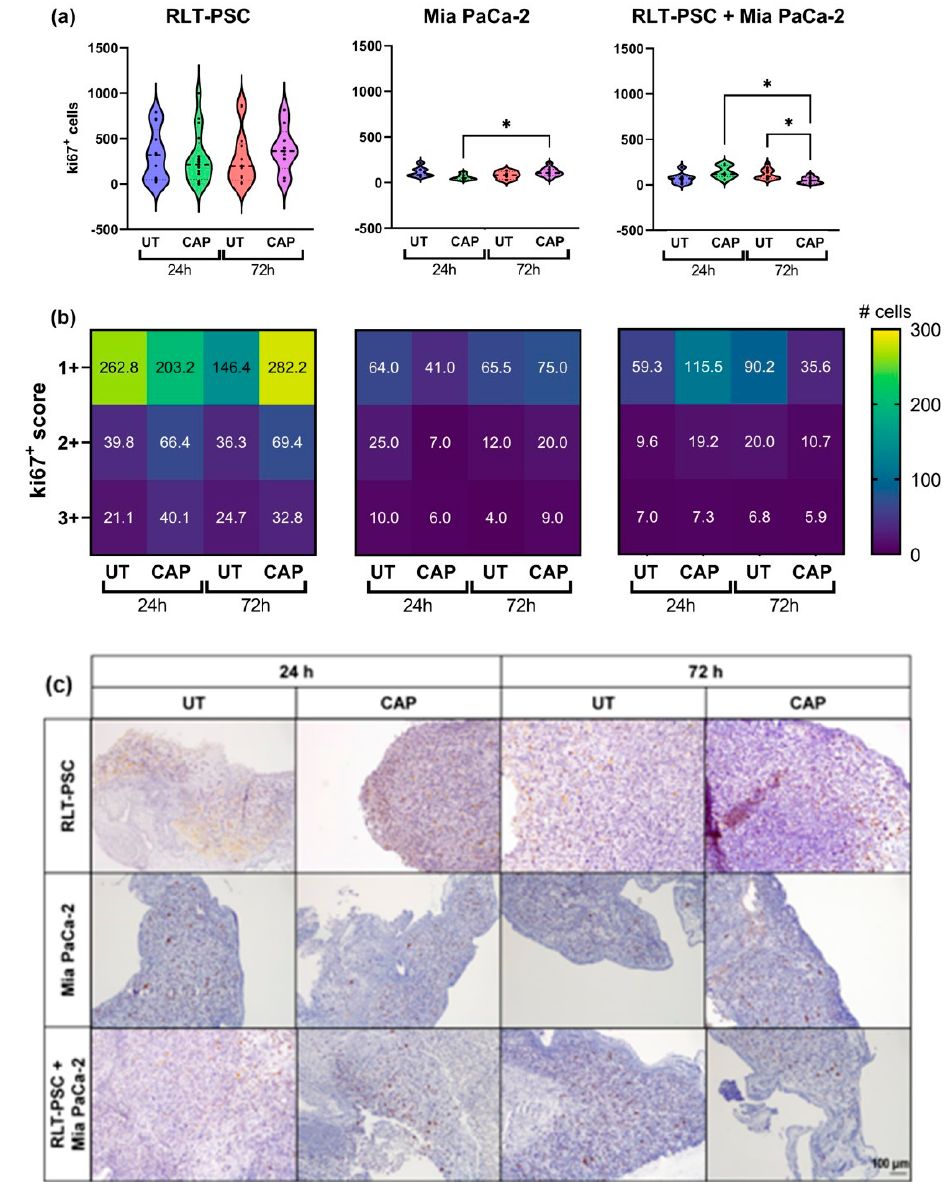
Figure 3. Ki67 expression in RLT-PSC, Mia PaCa-2, and RLT-PSC + Mia PaCa-2 tissue. ( a ) Total ki67 + counts for each tissue per treatment condition. Mixed-effects model (REML) with post-hoc Tukey’s test. Each dot represents one tissue. Dashed lines = median; dotted lines = 25% and 75% quartiles; * = p ≤ 0.05. ( b ) Tissue sections stained for Ki67 were scored using QuPath. Positive cells were classified as weak (1+), moderate (2+), or strong (3+) DAB signal. Heat maps present the mean values. UT = untreated control. n ≥ 4 tissue per condition. ( c ) Representative original images of samples stained for ki67 (DAB) and counterstained with haematoxylin (10× objective). Scale bar = 100 μ m.